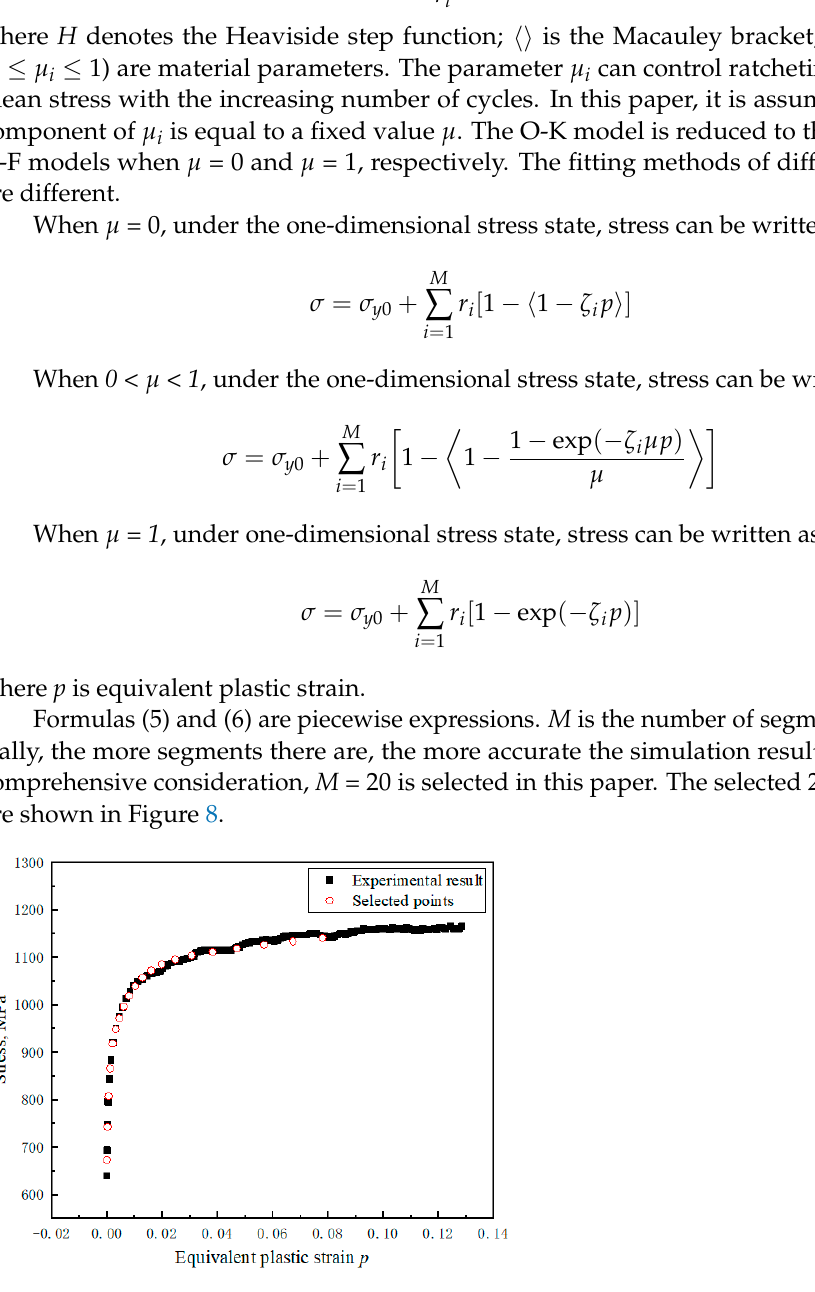
Figure 8. Selected points for parameter fitting.